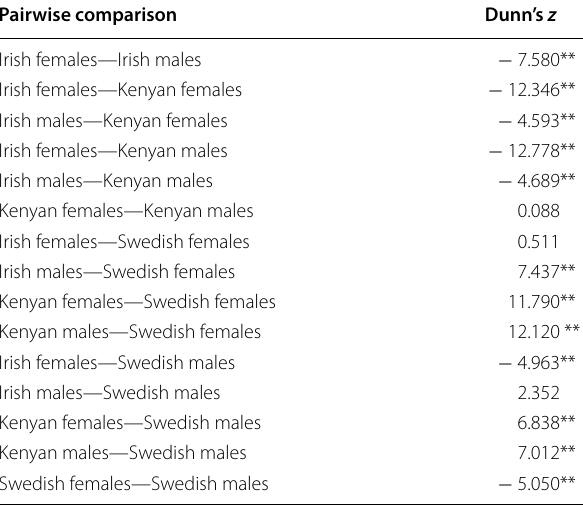
Table 6 Dunn’s pairwise comparisons in interested in becoming an